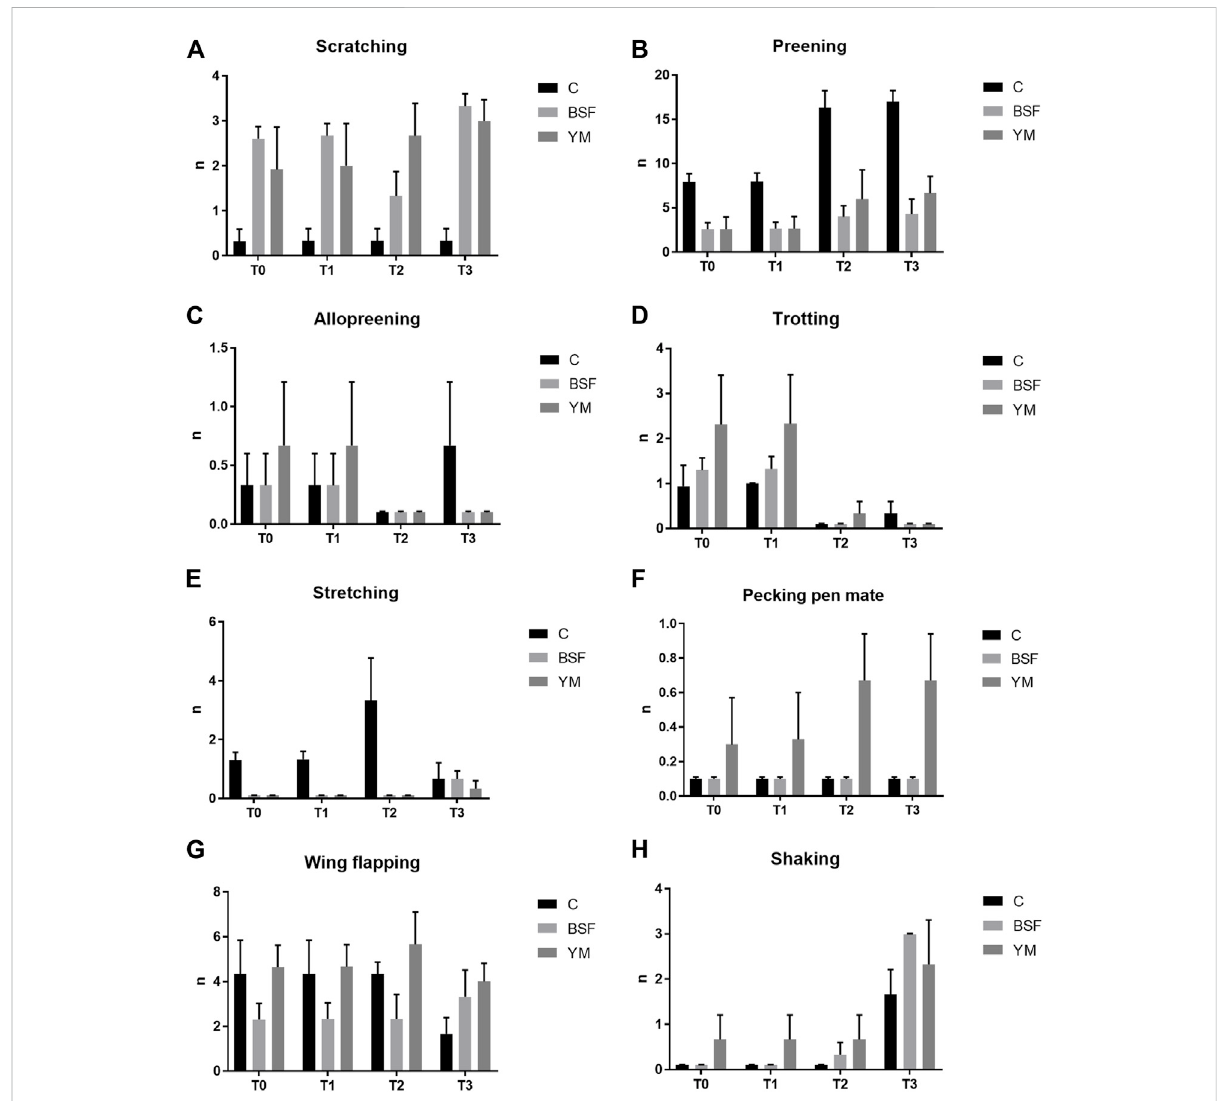
FIGURE 2 Frequency behaviours of the broiler chickens during the larvae intake (diet*time interaction, p > 0.05). (A) Scratching. (B) Preening. (C) Allopreening. (D) Trotting. (E) Stretching. (F) Pecking pen mate. (G) Wing fl apping. (H) Shaking. C = control group; BSF = C diet + black soldier fl y live larvae; YM = C diet + yellow mealworm live larvae. T0 = day 0; T1 = day 11; T2 = day 22; T3 = day